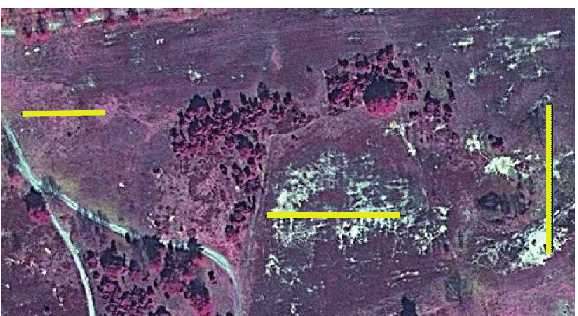
Figure 2. Location of the first three sample transects in the test